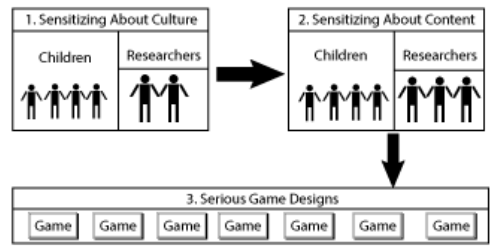
Figure 1. The Study Design: Cultural sensitizing, content sensitizing,